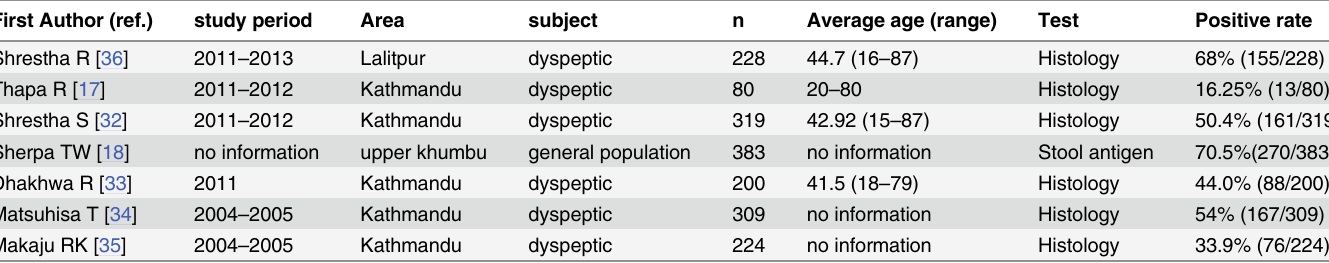
Table 5. Summary previous H . pylori prevalence studies in